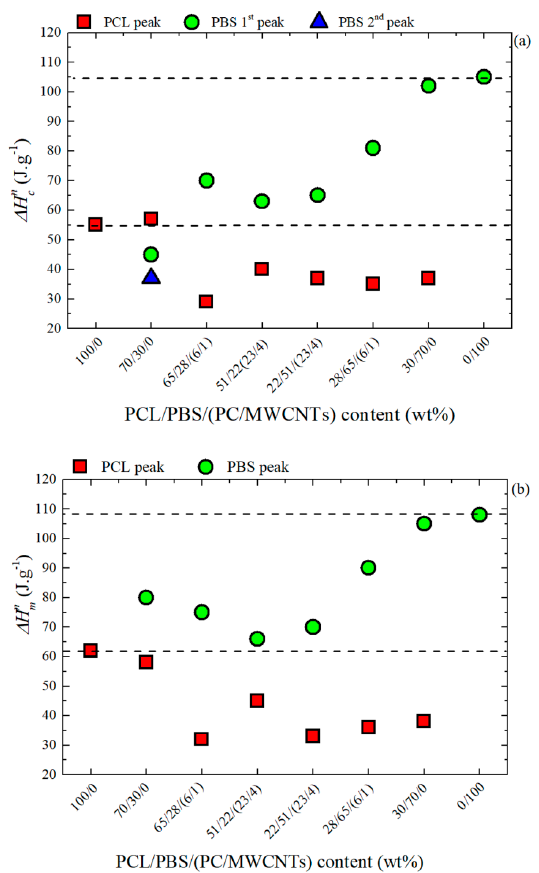
Figure 5. ( a ) Crystallization and ( b ) melting enthalpies for the PCL/PBS blends and the PCL/PBS/(PC/MWCNTs)